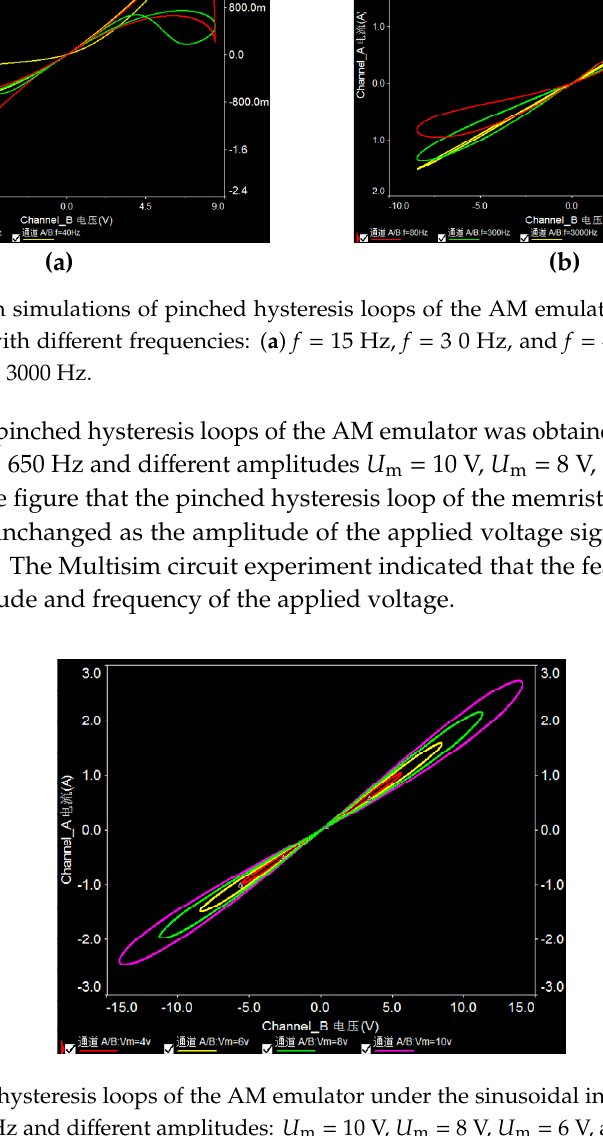
Figure 4. Pinched hysteresis loops of the AM emulator under the sinusoidal input voltage with the frequency f = 650 Hz and different amplitudes: U m = 10 V, U m = 8 V, U m = 6 V, and U m = 4 V.